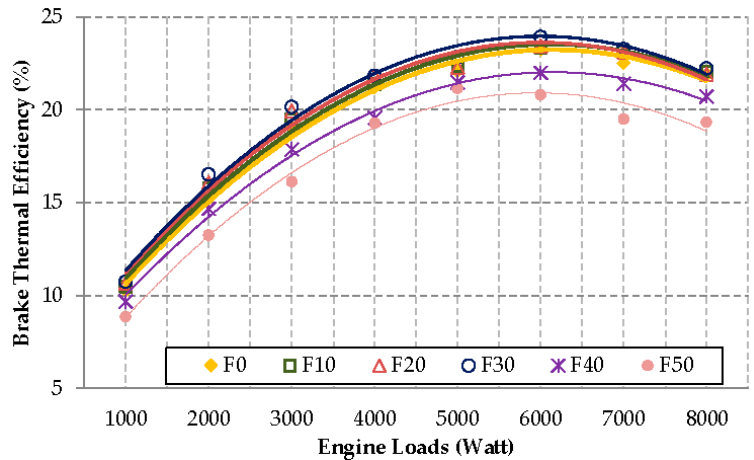
Figure 4. Brake thermal efficiency changes with engine loads.